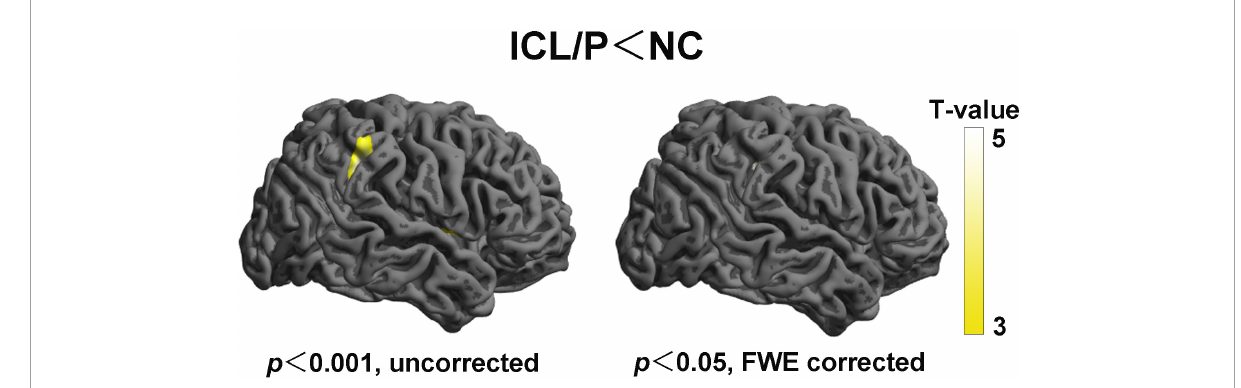
FIGURE2 Altered cortical thickness (CT) of the right hemisphere between the isolated clefts of the lip and/or palate (ICL/P) group and normal controls (NC). Statistical significance was p < 0.001, uncorrected (left) and p < 0.05, peak-level FWE-corrected (right). Color bars indicate T-values. The 3D brain maps [supplied by SPM12 (Statistical Parametric Mapping)] show the spatial location of intergroup different regions, shown on lateral views.